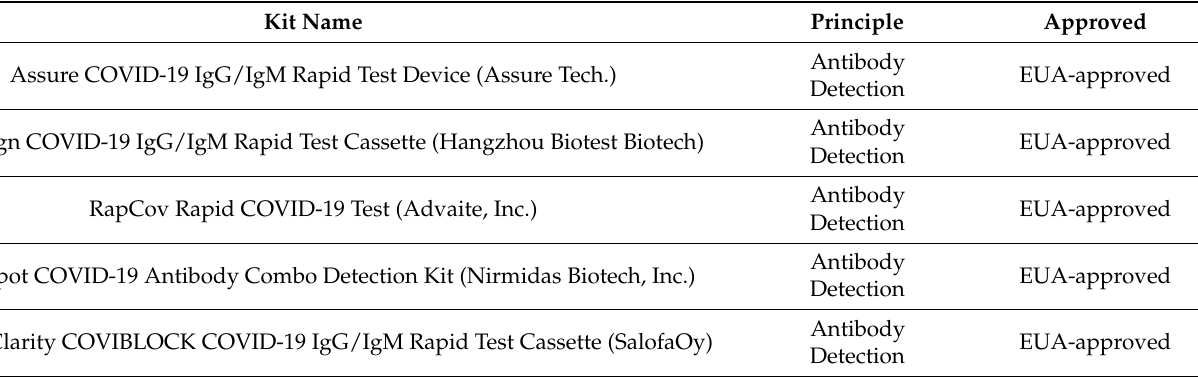
Table 6. List of EUA-approved POC devices working on antibody detection principle for SARS-CoV-19